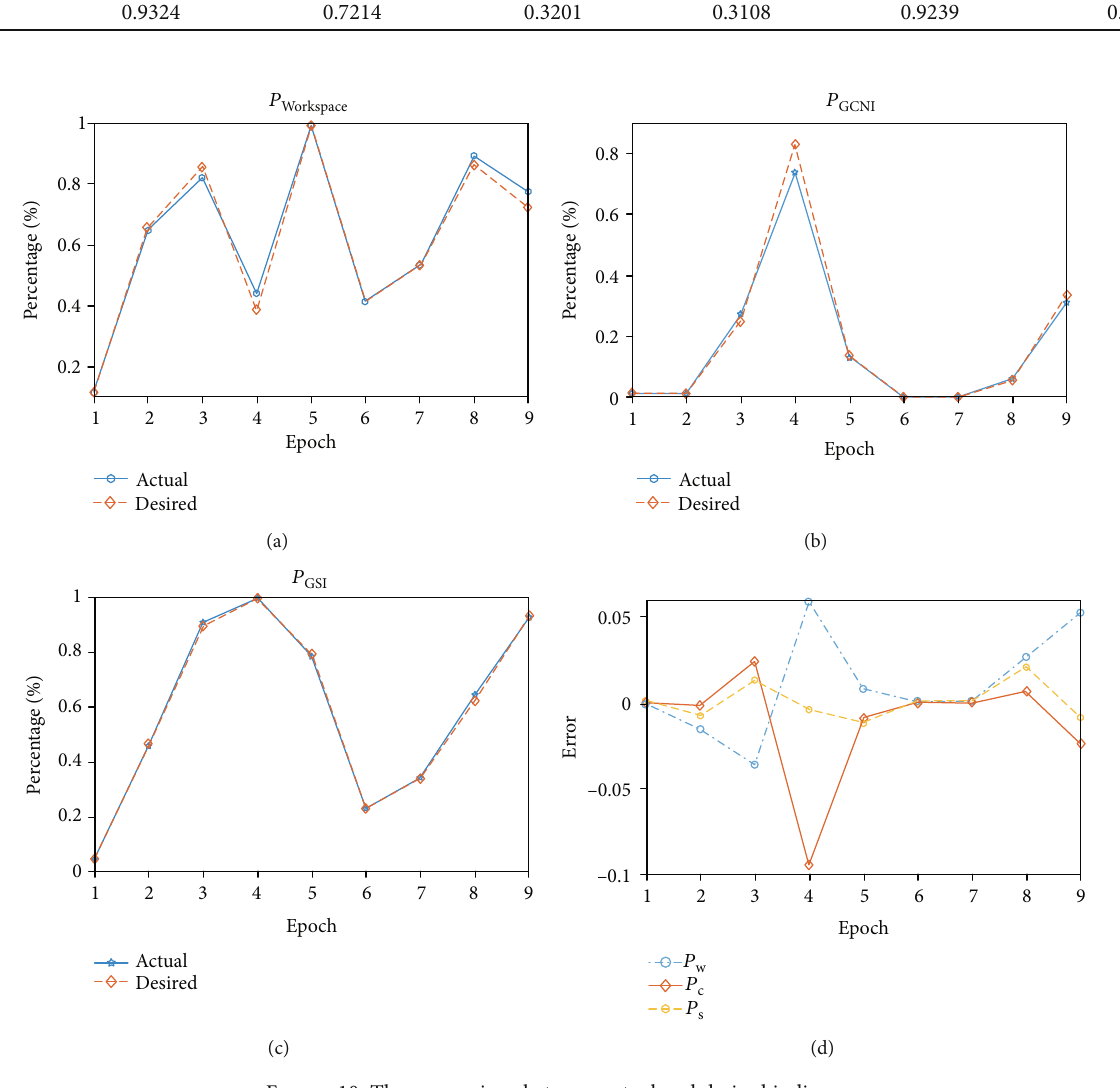
Figure 10: The comparison between actual and desired